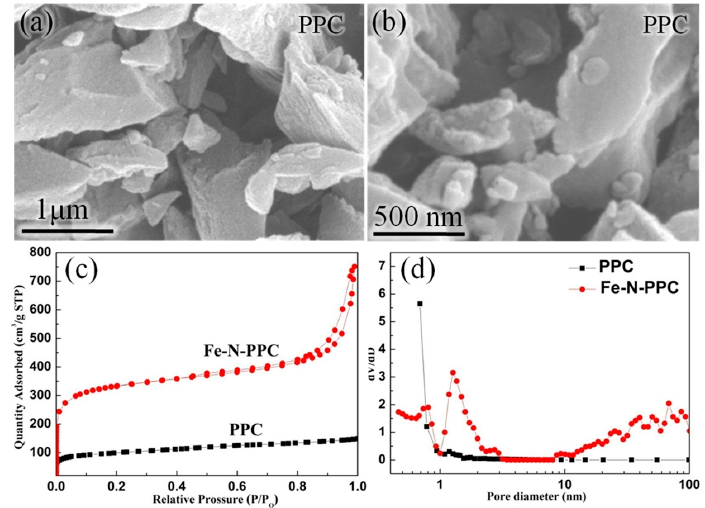
Figure 3. ( a , b ) Scanning electron microscopy (SEM) images of PPC; ( c ) N 2 adsorption–desorption isotherms and ( d ) Pore size distributions of PPC and Fe-N-PPC respectively.